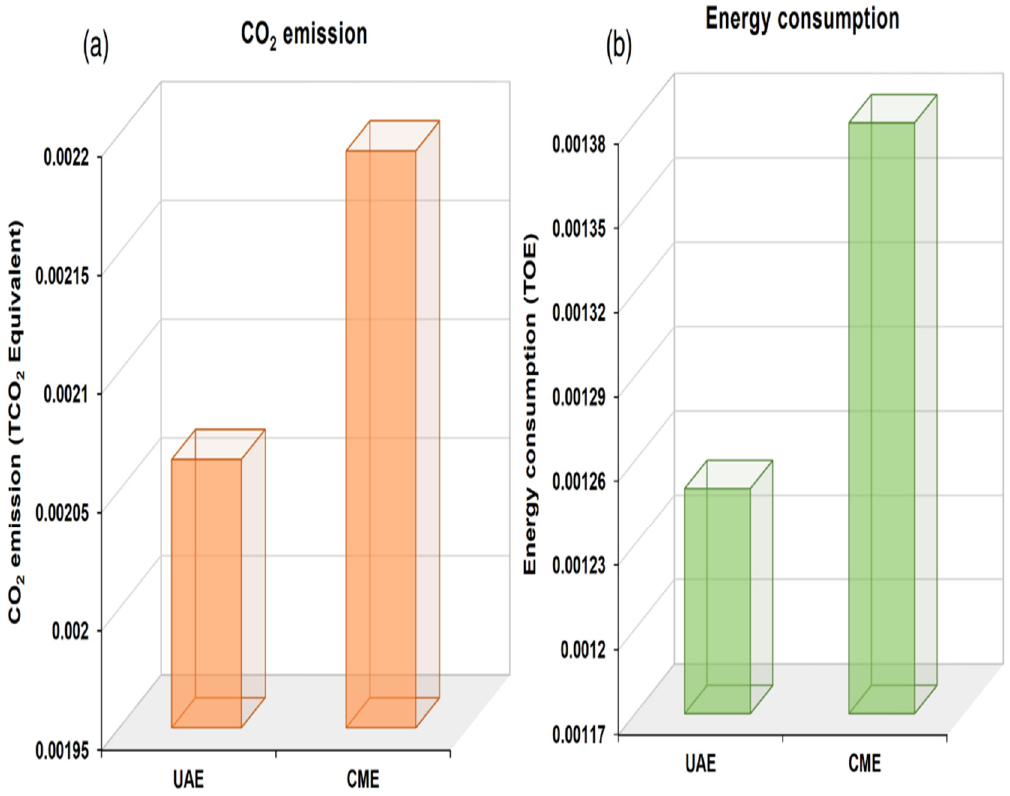
Figure 8. Efficiency comparison on the energy consumption ( a ) and CO 2 emission ( b ) from the UAE and CME extraction methods.